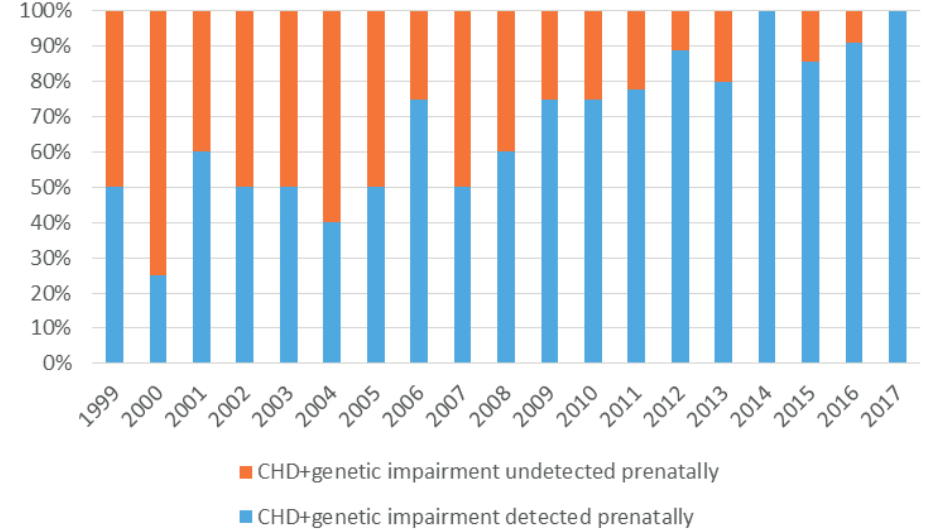
Fig. 2. Proportion of CHDs associated with a genetic diagnosis, prenatally and postnatally (n=128).